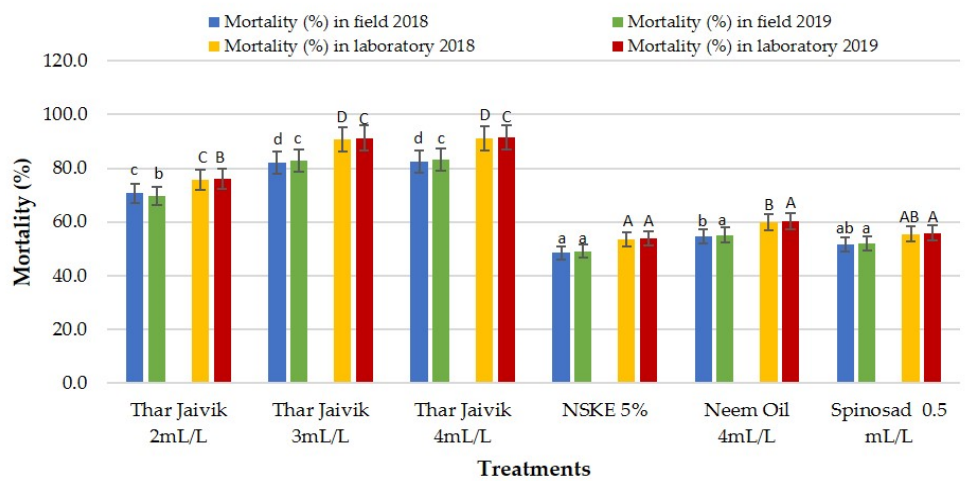
Figure 5. Efficacy of different concentrations of “Thar Jaivik 41 EC” and other biopesticides against T. citricida on citrus plants during 2018 and 2019 (mortality mean one and three days after application). NSKE: neem seed kernel extract. Different lowercase letters and uppercase letters indicate significant differences in treatments within field and laboratory conditions, respectively.